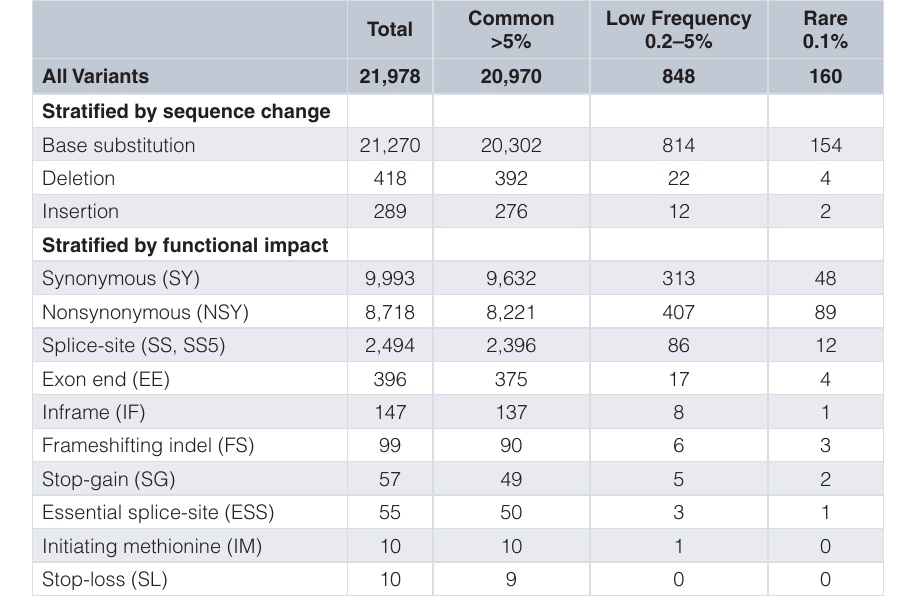
Table 1. Average number of exome variants per UK